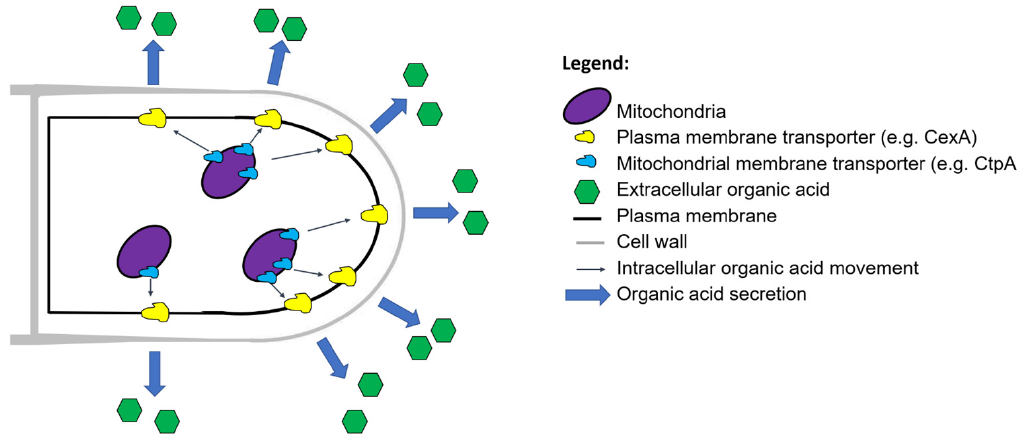
Figure 5. Schematic representation organic acid secretion by filamentous fungi. Many organic acids are intermediates of the Krebs cycle in the mitochondria. Under certain conditions, membrane transporters export organic acids firstly into the cytosol and then across the plasma membrane. Several such transporters have now been functionally characterized, but in general their location on the hypha (e.g., tip or intercalary regions) is unknown. Note that not all components are show and diagram is not to scale. Adapted from [3].